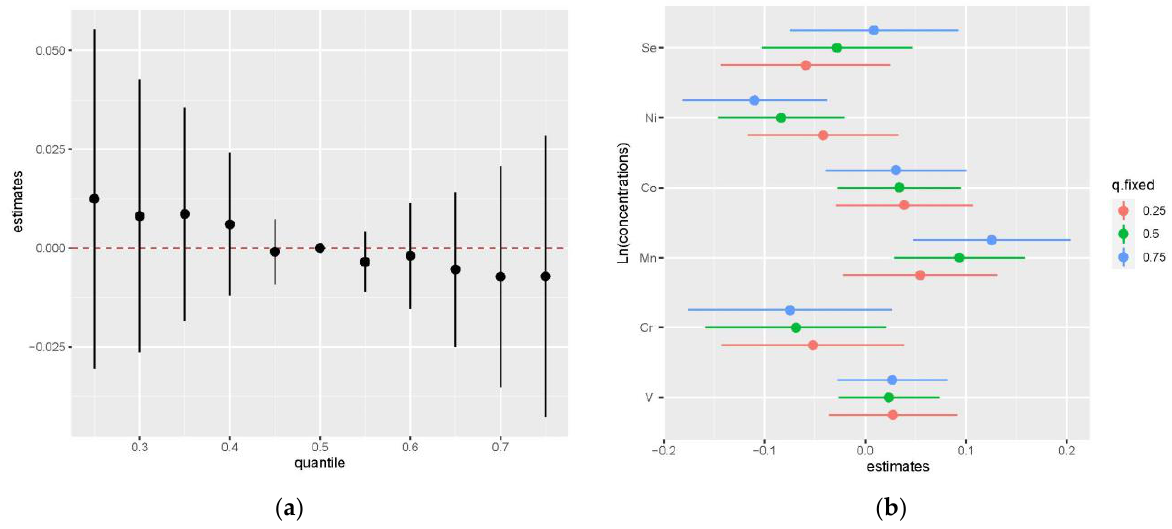
Figure 3. The joint effect of the trace element mixture on GDM by the BKMR model ( a ) The overall effects of element mixtures (estimates and 95% CI) in elements fixed to different percentiles compared to when they were at their medians (P50). ( b ) The effects of single exposure when an individual element was at its 75th percentile compared to when that exposure was at its 25th percentile, where all other exposures were fixed to a particular quantile (P25, P50, and P75). The results were adjusted by family history of diabetes, education level, ethnic groups, TG, and LDL-cholesterol.